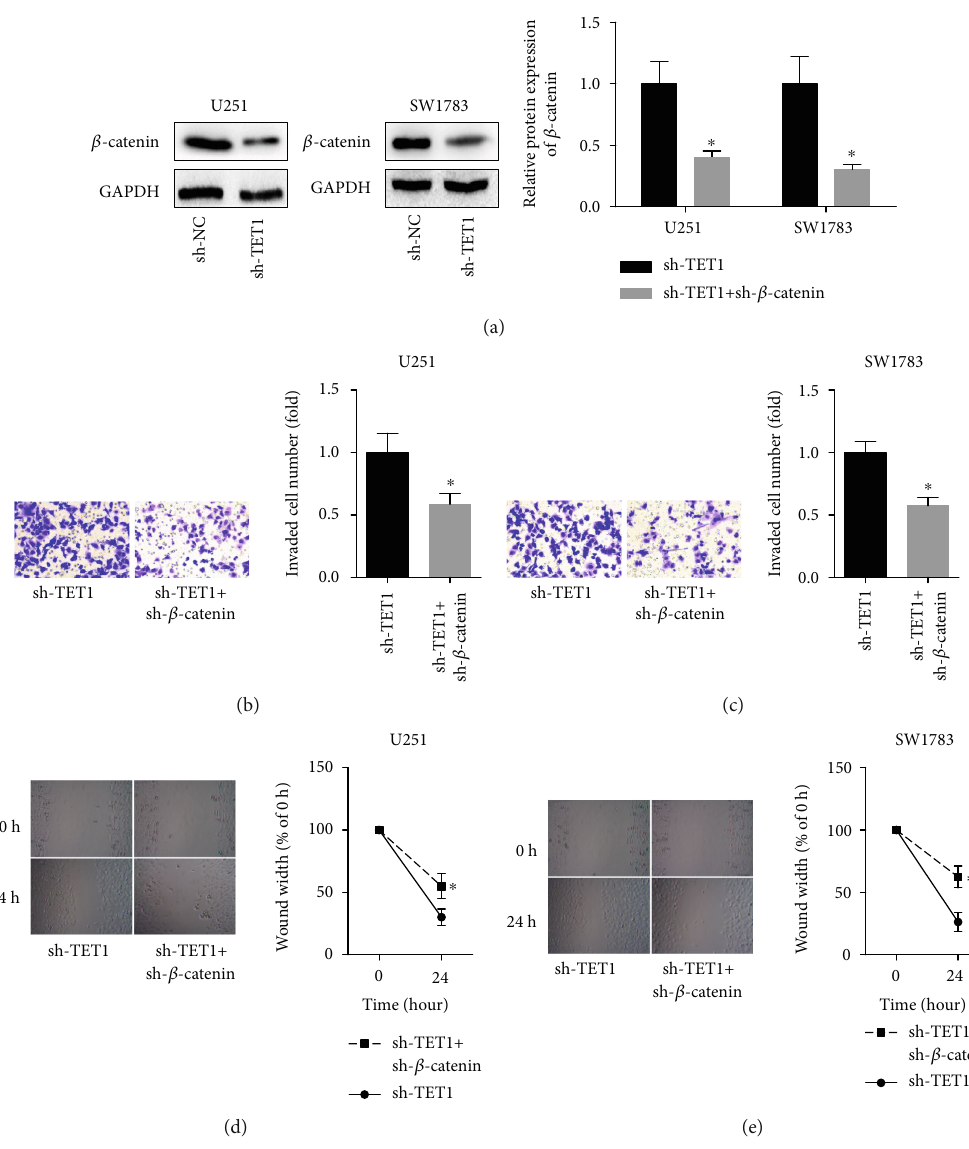
Figure 7: Downregulation of β -catenin inhibited cell migration and invasion. (a) Western blot and RT-qPCR were used to validate the e ffi ciency of β -catenin shRNA. (b, c) Transwell experiments were adopted to determine the invasion of U251 and SW1783 cells. (d, e) Wound healing assay was taken to calculate the migration of U251 and SW1783 cells. ∗ P < 0 : 05 .